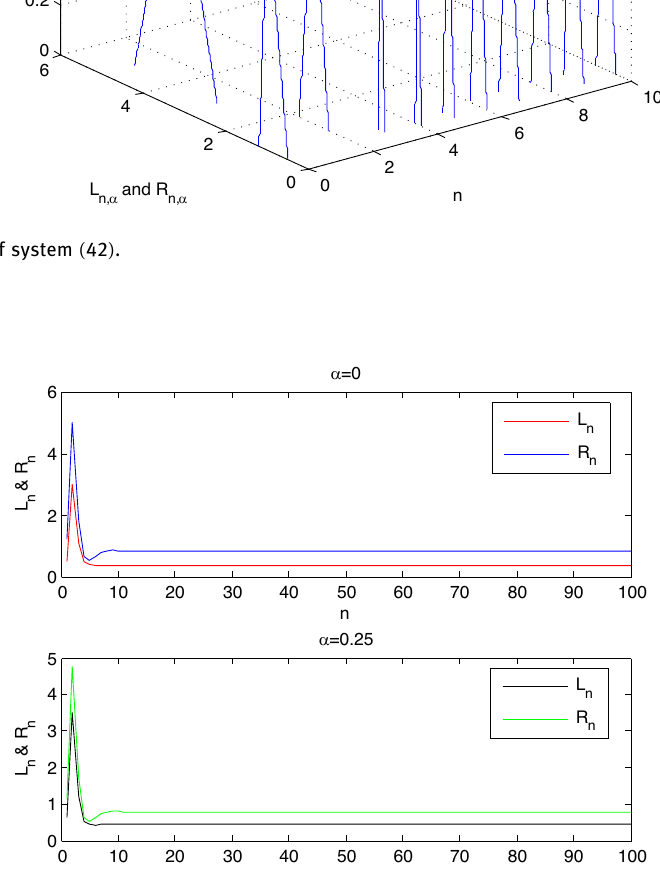
Figure 2: The solution of system ( 48 ) at = α 0 and = α 0.25 .